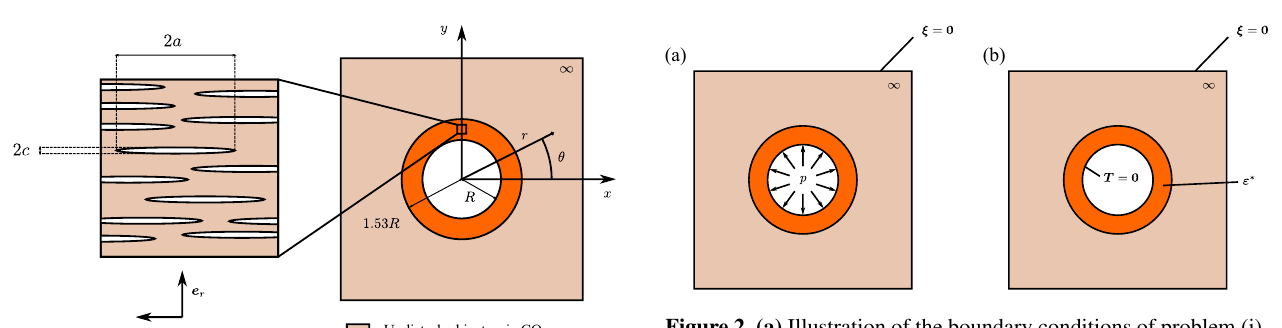
Figure 2. (a) Illustration of the boundary conditions of problem (i). (b) Illustration of the boundary conditions of problem